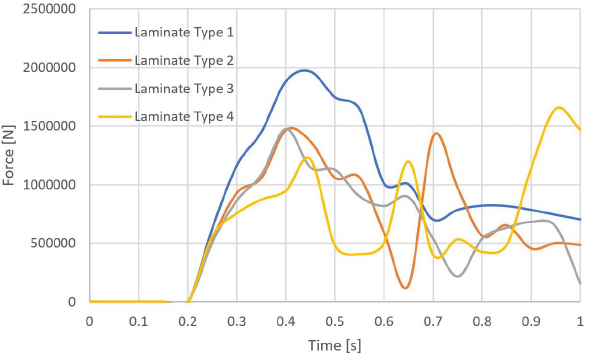
Figure 30: Force – Time of each type of laminate based on impact at a speed of 4 knots